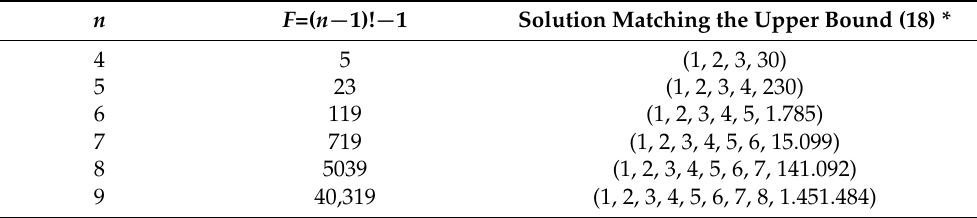
Table 2. Smallest sums of terms of distinct-term solutions of ∏ n x i matches the upper bound such that ∑ n i = 1